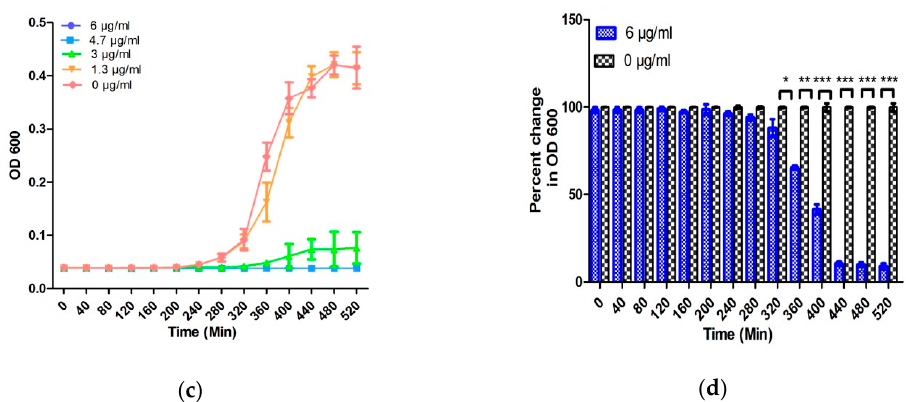
Figure 4. The graphs represent AST evaluation in artificial urine samples: ( a ) the change in OD 600 nm with time in 10 6 CFU/mL E. coli samples, ( b ) the percentage change in the OD 600 nm between control and antibiotic-treated 10 6 CFU/mL E. coli samples , ( c ) the change in the OD 600 nm with time in 10 4 CFU/mL E. coli samples, and ( d ) the percentage change in the OD 600 nm between control and antibiotic-treated 10 4 CFU/mL E. coli samples. Error bars represent the standard deviation from the mean values of three experiments (significance indicators: * p < 0.05, ** p < 0.01, and *** p < 0.001).